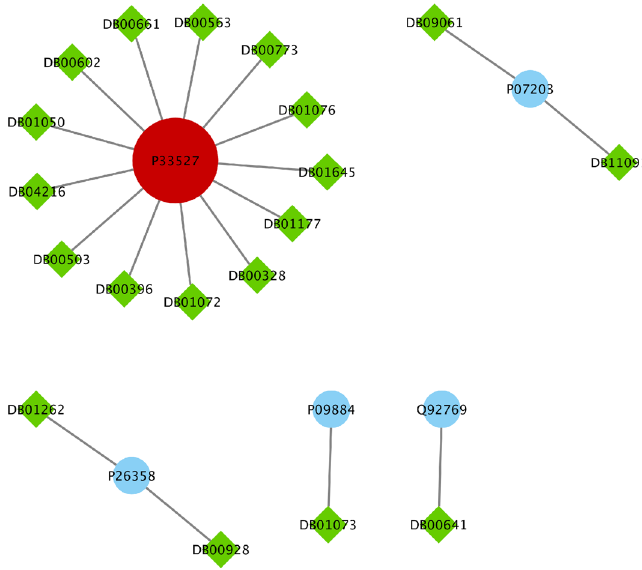
Figure 8. The drug targets in Clinical-Drug group that are located in T 2